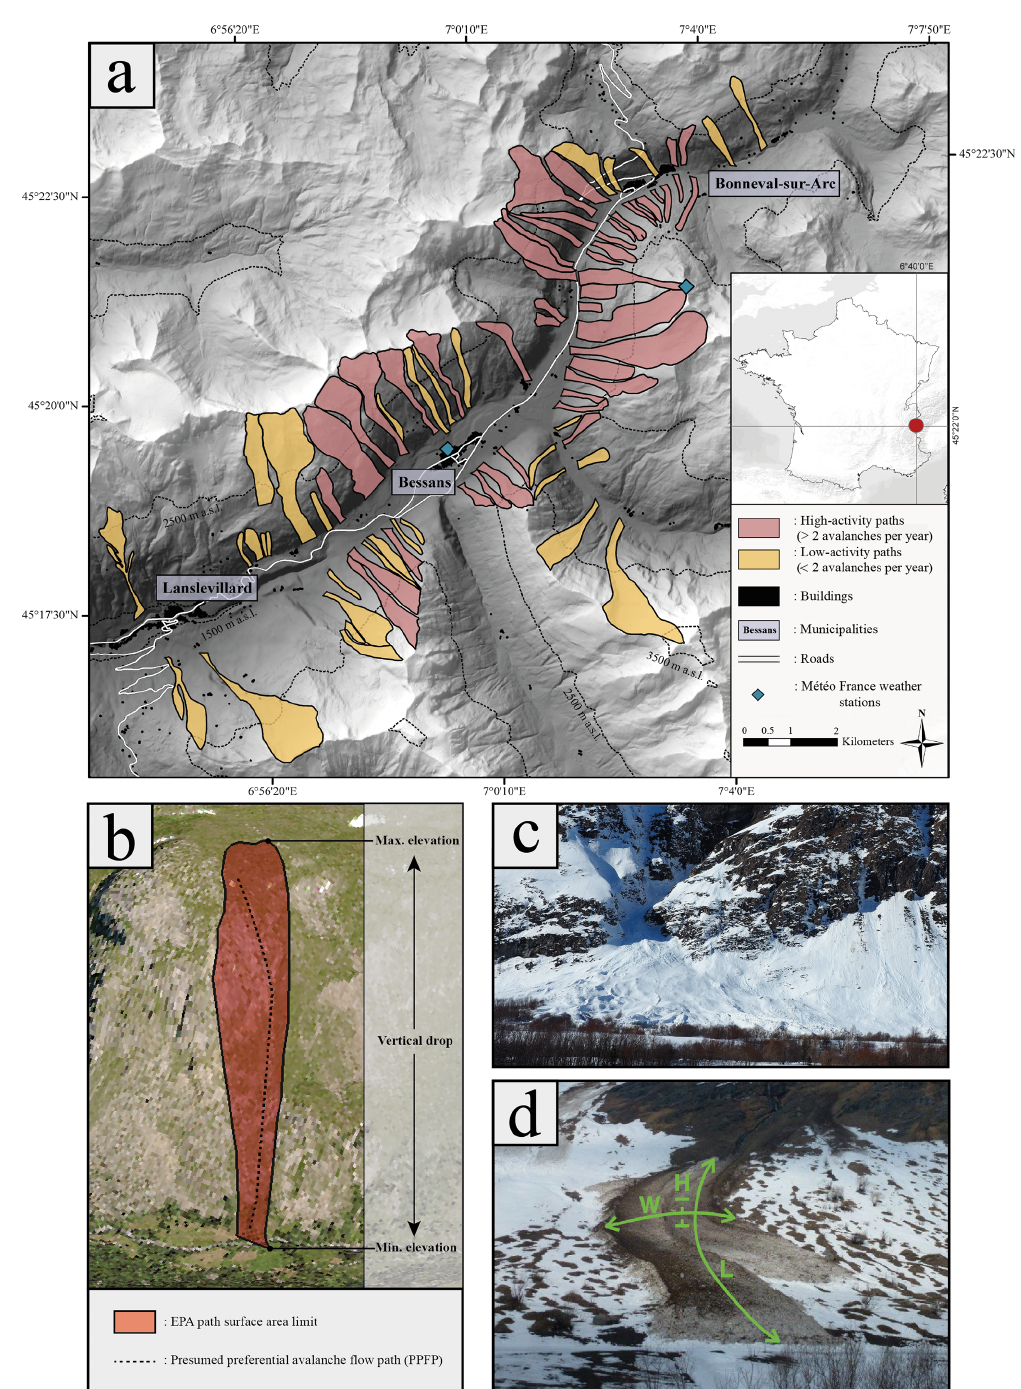
Figure 1. (a) Study area: snow avalanche paths from the EPA database and avalanche activity according to our completed database in the upper part of the Maurienne valley, French Alps, between April 2003 and 2017/18. (b) Example of morphological characteristics of an avalanche path from the EPA database (path no. 44, Bessans). (c) Snow avalanche deposit in Bessans (© INRAE ETNA, 2018). (d) Method for visually estimating the deposit volume. H : height; W : width; L : length (© INRAE ETNA, Bessans, 2019).